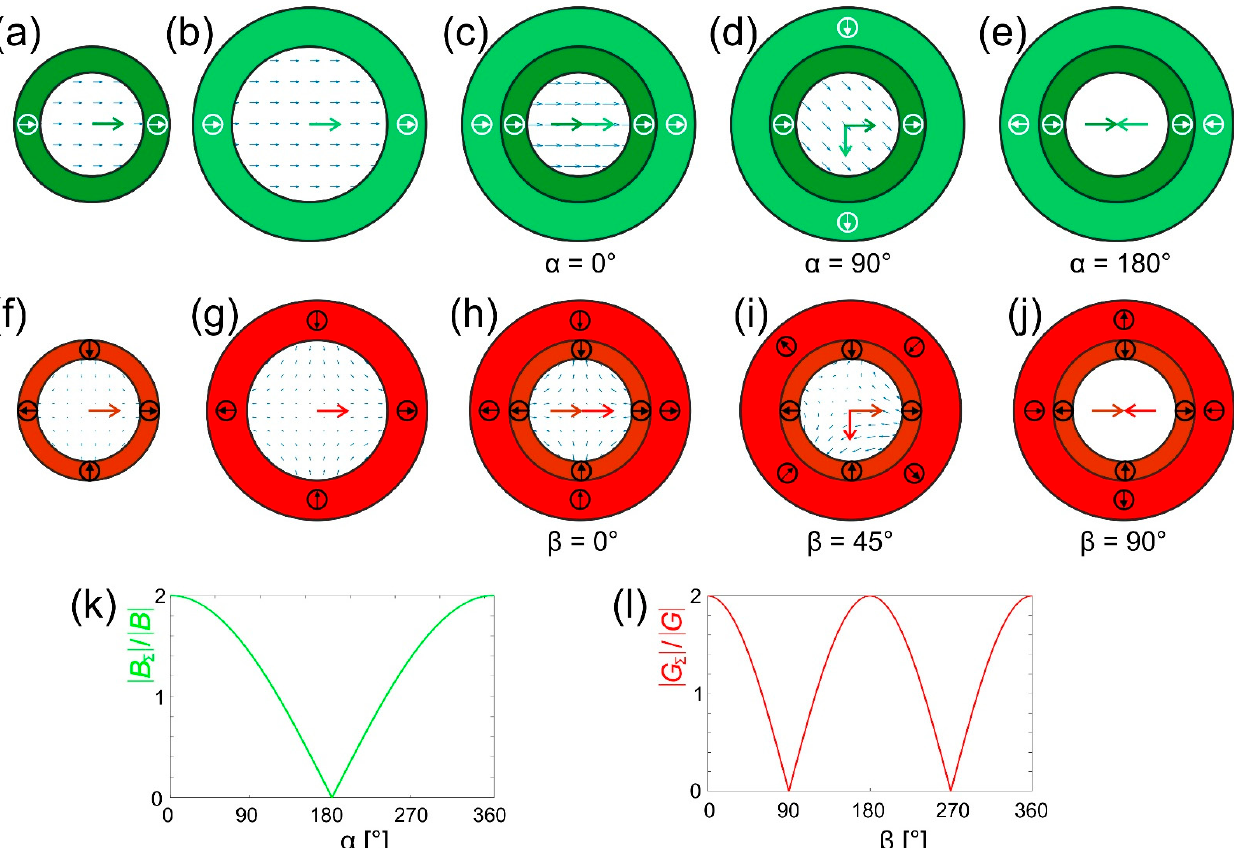
Figure 3. Coaxial arrangement and rotation of Halbach dipoles (green, upper row) and quadrupoles (red, lower row): ( a ) and ( b ) two Halbach dipoles that produce the same field strength, B (central green arrow); are coaxially nested in ( c – e ) and the outer one is rotated by an angle α . The resulting field is also illustrated by B -arrows. ( c ) For α = 0°, the fields are parallel and the two dipole fields add to 2 B . ( d ) For α = 90°, the fields are orthogonal and the two dipole field vectors add to 2 B at an angle of 45°. ( e ) For α = 180°, the fields are antiparallel and cancel each other. An analog presentation is shown in ( f , g ) for two nested quadrupoles that produce the same field gradient (i.e., the derivative of the field. The red arrow shows the horizontal component only). ( h – j ) Same representation as above. Note that the gradient rotates at twice the angle of the quadrupole (cf. Appendix C). ( k ) The angular dependence of the combined field of both dipoles, B Σ = 2 ( l ) angular dependence of the gradient strength of the two quadrupoles G Σ =